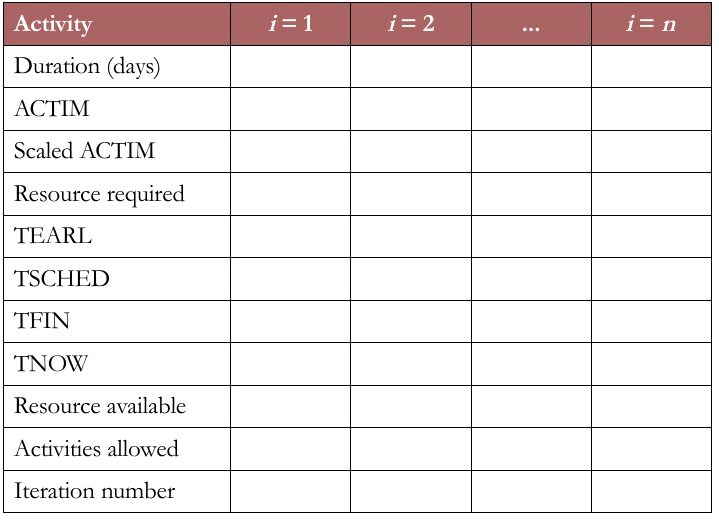
Table 1. Heuristic Scheduling Using ACTIM Source: Project Management in Manufacturing and High Technology Operations (Badiru,